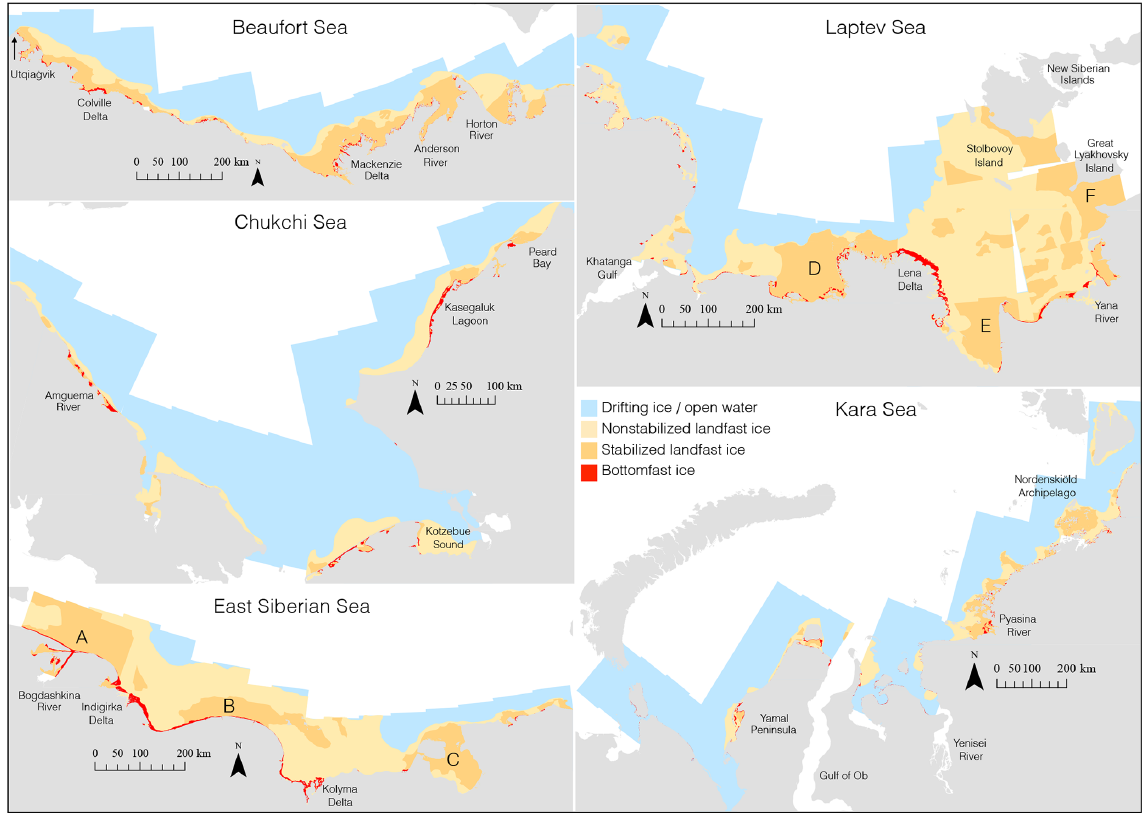
Figure 9. InSAR-derived map of nonstabilized and stabilized landfast ice and bottomfast ice from Sentinel-1 image pairs, acquired predom- inantly between March and May 2017. Letters A–G mark areas discussed in the text. Land is masked out in light grey. This map of stability zones is subject to limitations and uncertainties outlined in the